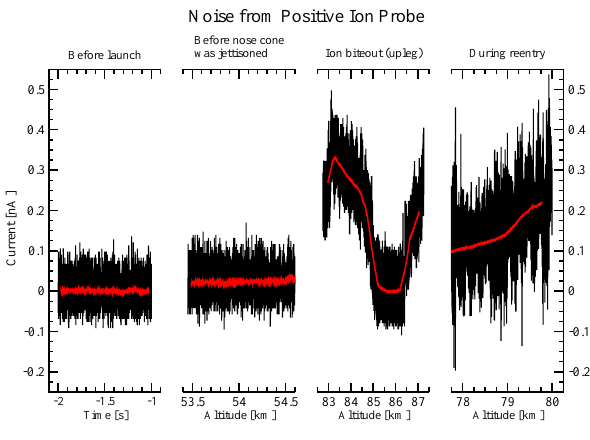
Fig. 3. The current measured by the PIP at different times before and during the flight. The red line is a running mean over ∼ 1 spin